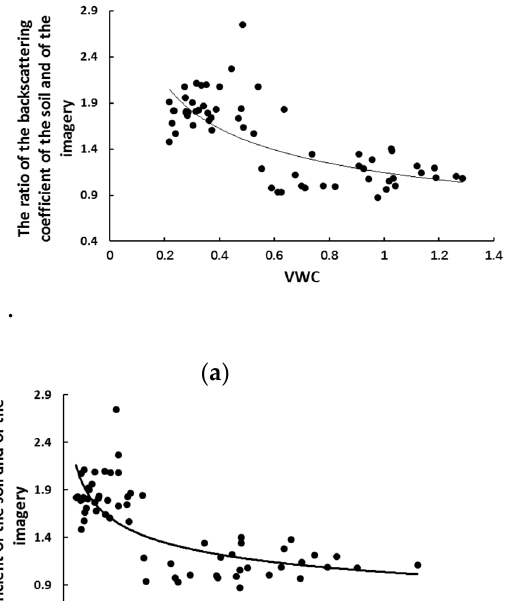
Figure 6. The ratio scatter plots of 𝜎 (cid:3035)(cid:3035)(cid:3046)(cid:3042)(cid:3036)(cid:3039)(cid:3042) /𝜎 (cid:3035)(cid:3035)(cid:3042) to vegetation indices ( a ) VWC; ( b ) NDVI; ( c ) EVI.